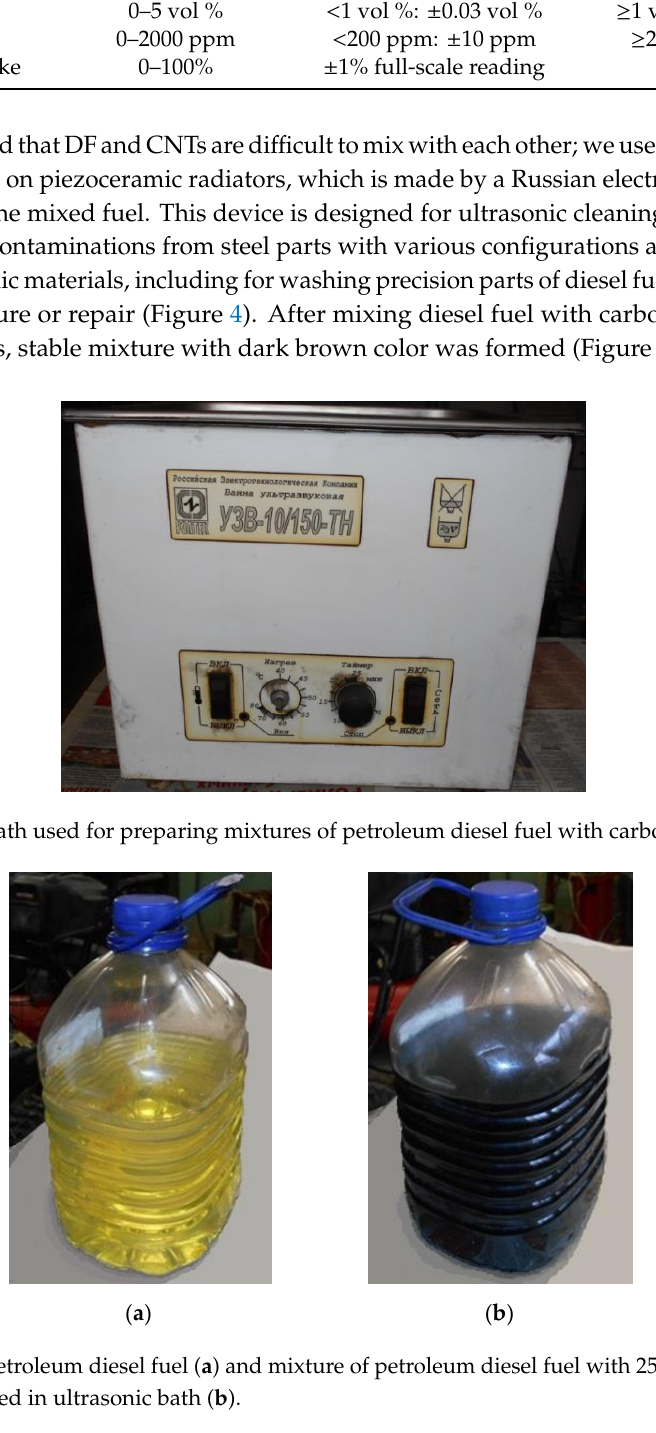
Figure 3. Smoke meter ( a ) and exhaust gas analyzer ( b ). Table 2. Main measurement parameters.